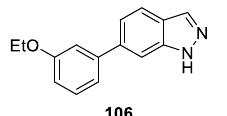
Figure 18. Chemical structure of 1 H -indazole derivative 106.